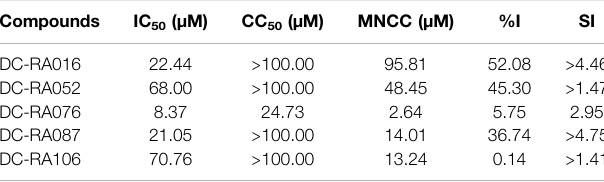
TABLE 1 | Summary of Anti-SARS-CoV-2-S pseudovirus activities and cytotoxicities of fi ve compounds.